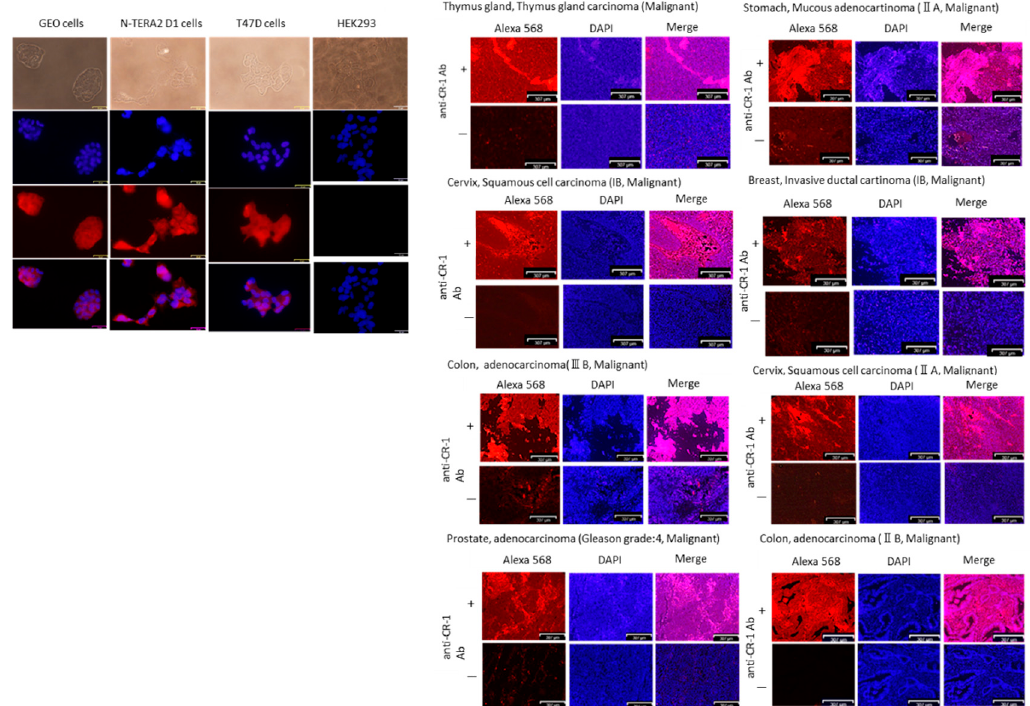
Figure 7. Immunostaining of cancer cell lines and tissues with anti-CR-1 antibody Clone 35: ( A ) Immunoreactivity of anti-CR-1 antibody on cell lines overexpressing CR-1. HEK293 cells are the negative control of CR-1 expression. Scale bars = 32 µm. ( B ) Immunoreactivity of human tissue-microarray with anti-CR-1 antibody. Anti-human IgG conjugated with Alexa 568 was used as the secondary antibody. Negative control was assessed without the primary antibody (Figure S1). Scale bars = 300 µm.